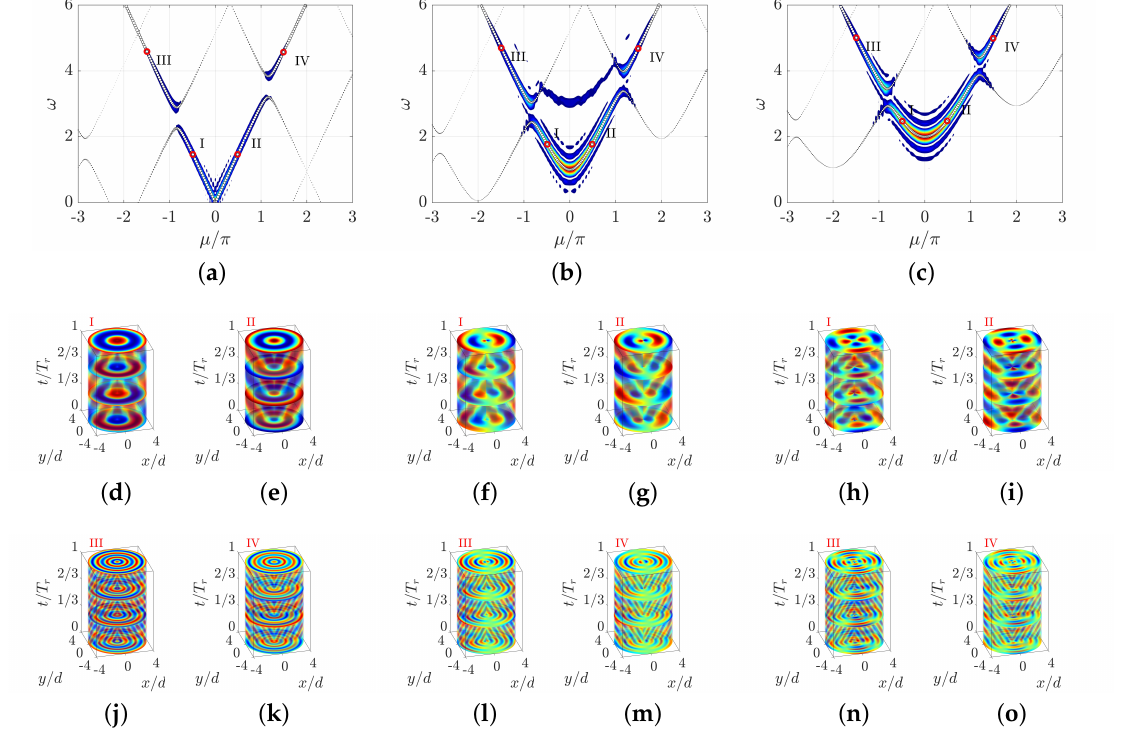
Figure 5. ( a – c )Numerical dispersion relation (colored contours) for a space–time modulated SRC with superimposed PWEM solution (white dots). ( a ) q = 0; ( b ) q = 1; ( c ) q = 2. The Bloch-wave solutions corresponding to µ / π = ± 0.5 and µ / π = ± 1.5 are marked with red dots. The corresponding modes are illustrated below for ( d , e , j , h ) q = 0, ( f , g , l , m ) q = 1, and ( h , i , n , o ) q =